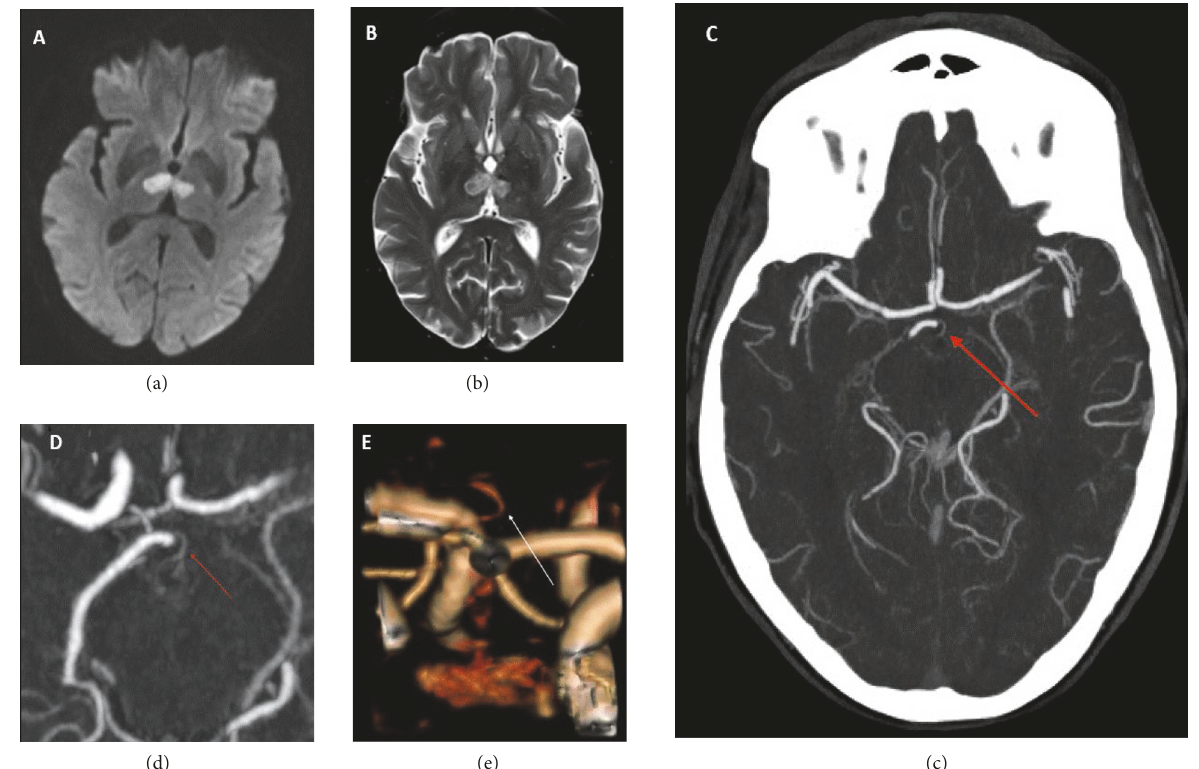
Figure 1: MRI brain diffusion weighted imaging series (a) and T2 (b) demonstrating bilateral paramedian thalamic infarcts. CTA vessel study. (c) Axial-Maximum Intensity Projection (MIP); (d) axial-3D-MIP; and (e) reconstructed 3D image demonstrates an Artery of Percheron (arrow) arising from the right Posterior Cerebral Artery P1 segment.